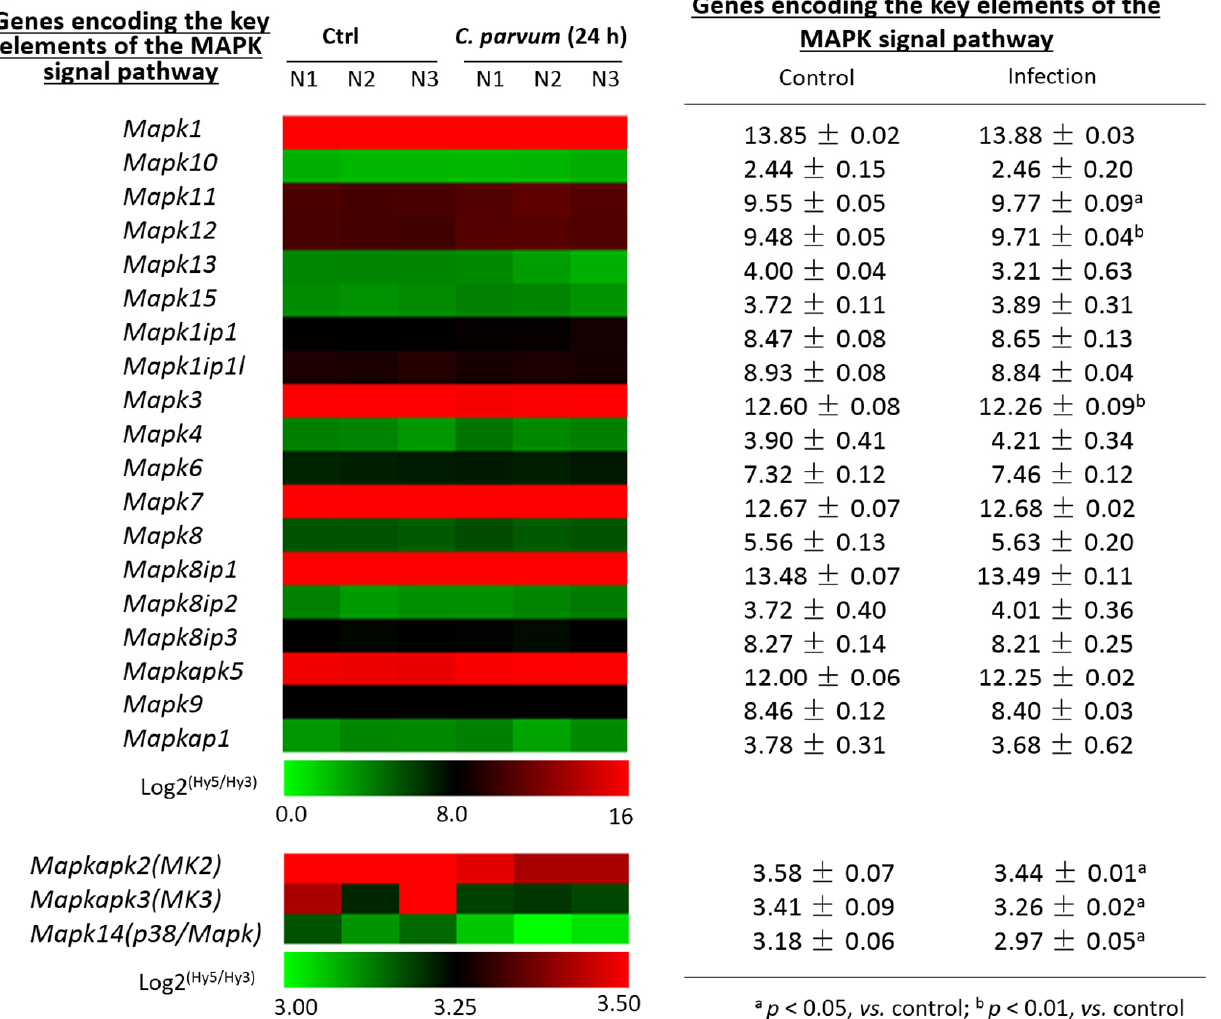
Figure 2. Expression profile of genes key to the MAPK signaling pathway in intestinal epithelial cells following C. parvum infection. Heatmap of expression levels of genes key to the MAPK signal pathway in host cells following C. parvum infection, presented as the log2 (Hy5/Hy3) ratios, which passed the filtering criteria variation across the samples ( n = 3). IEC4.1 cells were exposed to C. parvum infection for 24 h and RNA was isolated for genome-wide transcriptome analysis via microarray. Expression levels of genes key to the MAPK signal pathway are shown. a p < 0.05, vs. control; b p < 0.01, vs. control.